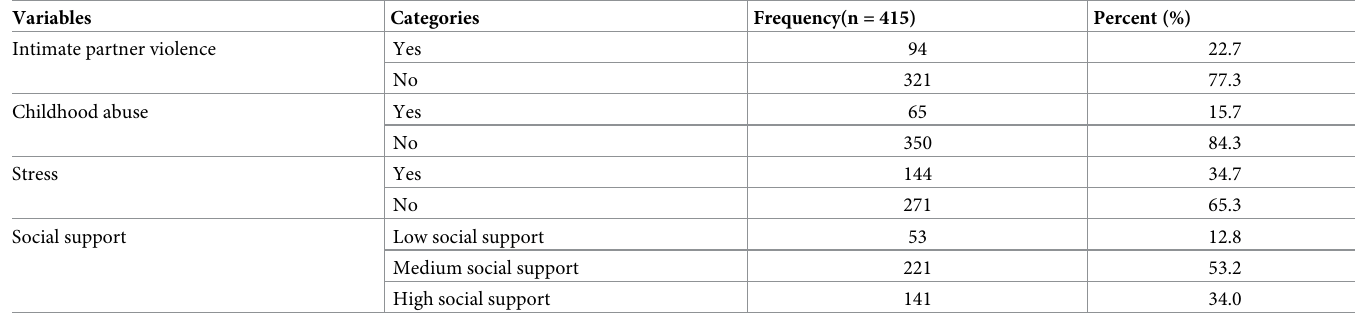
Table 4. Psychosocial factors among pregnant women attending antenatal care at Jimma medical center, Jimma, Southwest, Ethiopia, 2020 (n = 415).